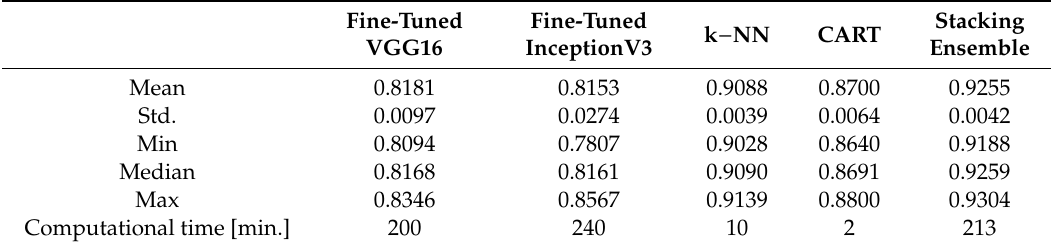
Figure 11. Results of learning models. Table 4. Descriptive statistics of model f1 score in 5-folding cross-validation.